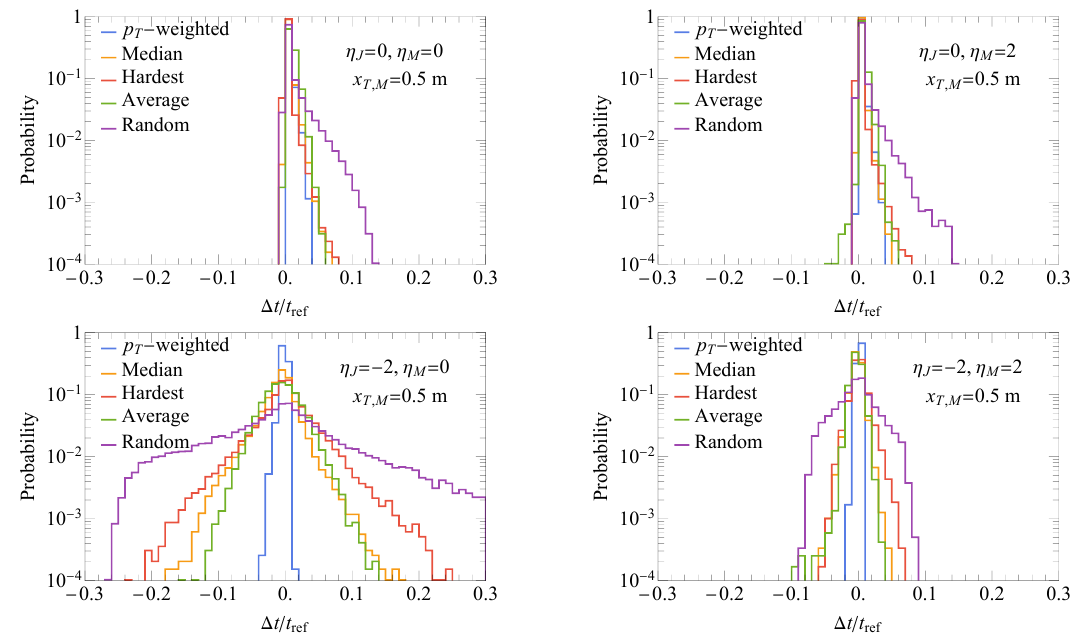
Figure 11 . The relative time difference distribution for ( η J , η M ) = (0 , 0) (top left), ( η J , η M ) = (0 , 2) (top right), ( η ) = ( − 2 , 0) (bottom left), and ( η J , η M x T,M = 0 . 5